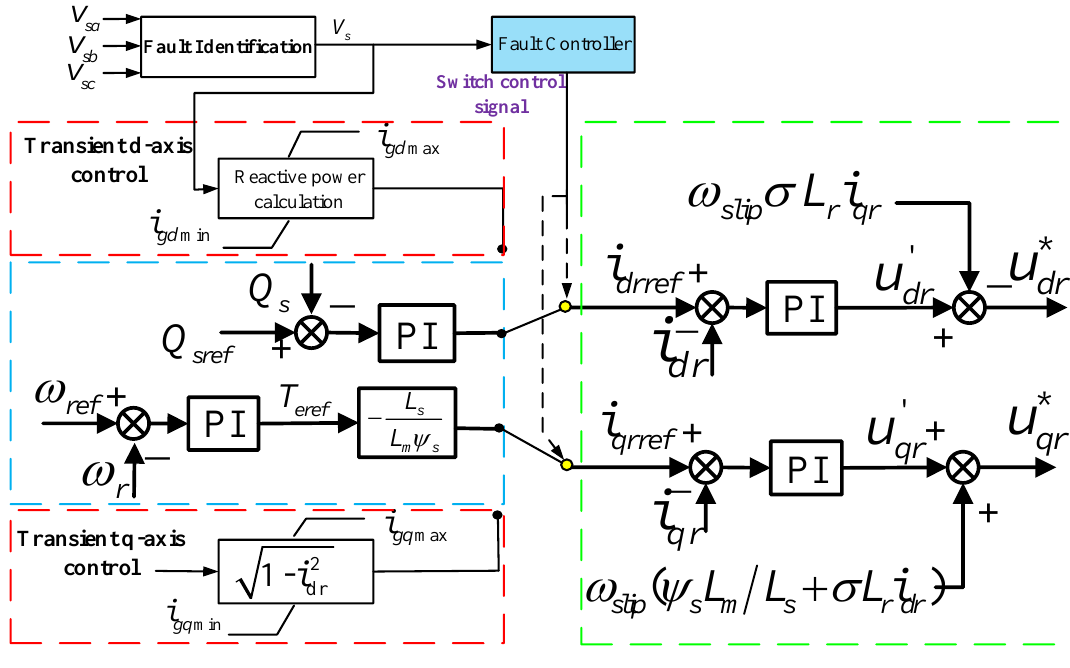
Figure 8. Controllers of rotor-side converter